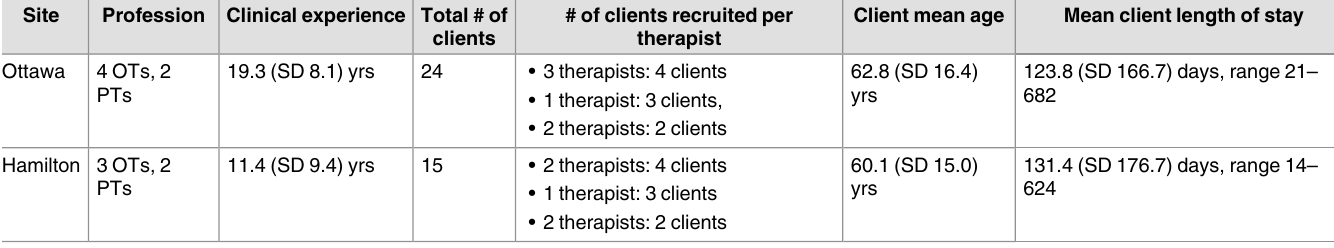
Table 3. Participant and client